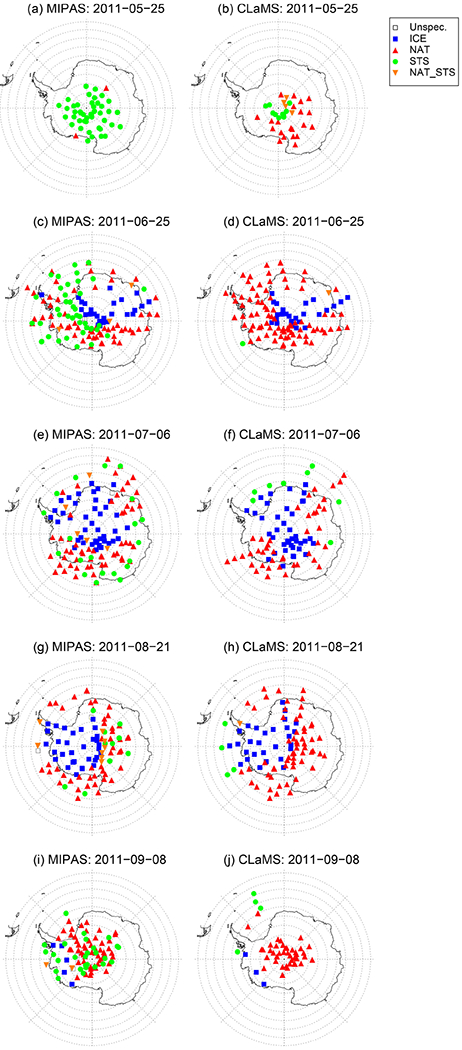
Same as Fig. 4 but for certain days in SH winter 2011: 25 May (a, b), 25 June (c, d), 6 July (e, f), 21 August (g, h), and 8 September (i, j).